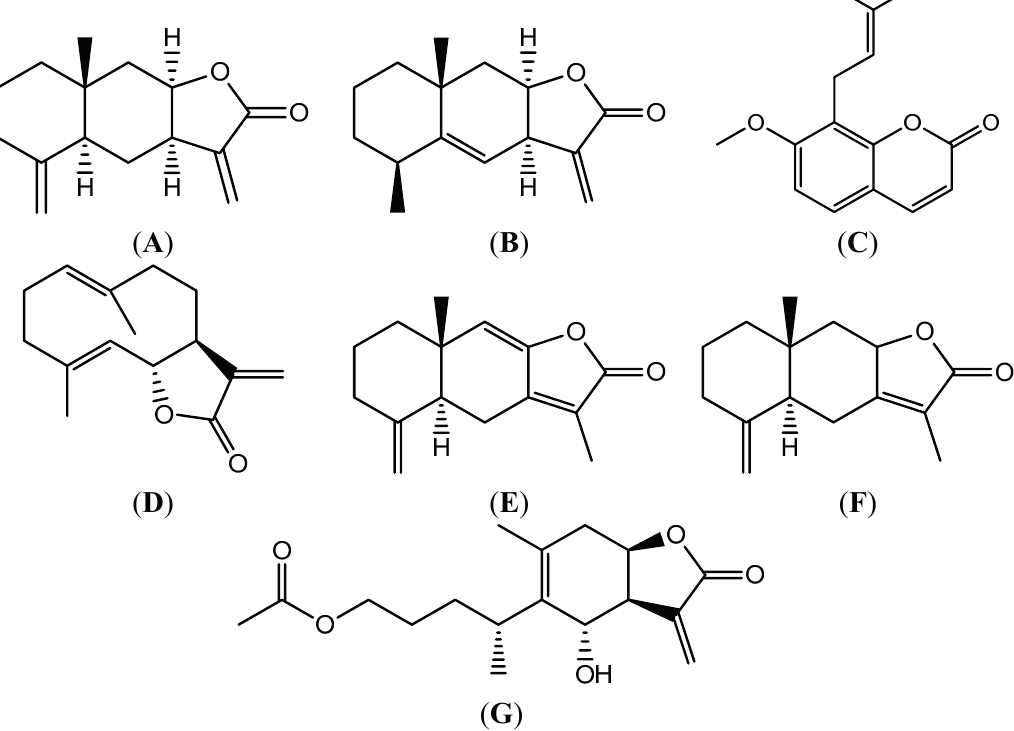
Figure 1. Structures of isoalantolactone ( A ), alantolactone ( B ), osthole ( C ), costunolide ( D ), atractylenolide I ( E ), atractylenolide II ( F ) and 1-acetoxy-6 α -hydroxyeriolanolide ( G